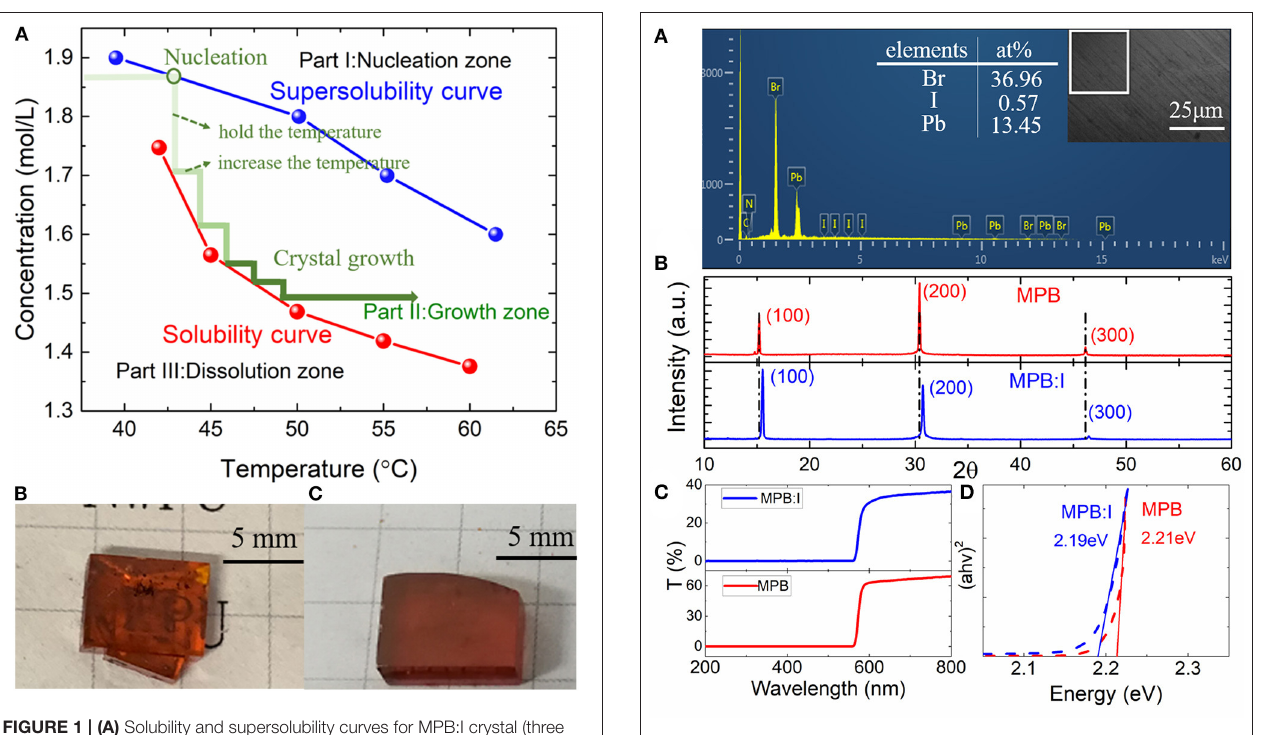
were measured from 200 to 800 nm, as shown in Figure 2C